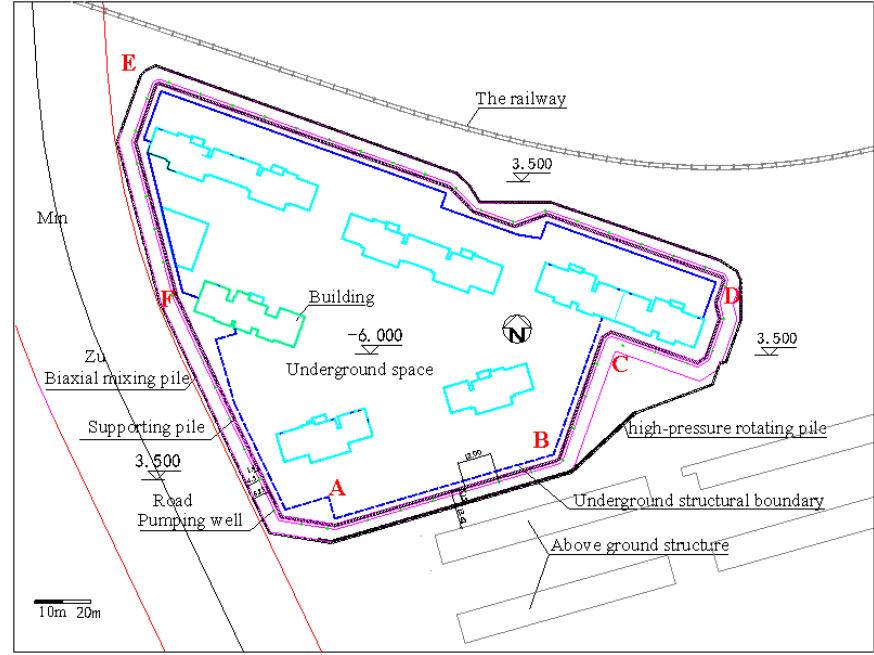
Figure 12. Foundation pit plan.